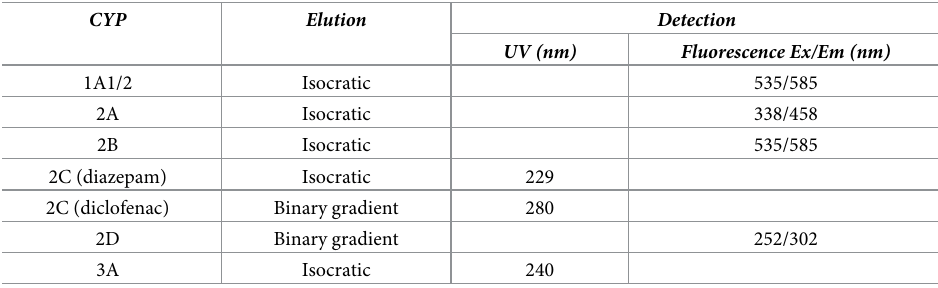
Table 1. HPLC conditions for the measurement of enzyme activity